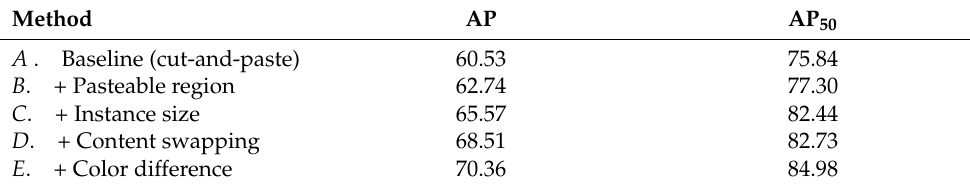
Table 1. Experimental results on CSS138 validation set.